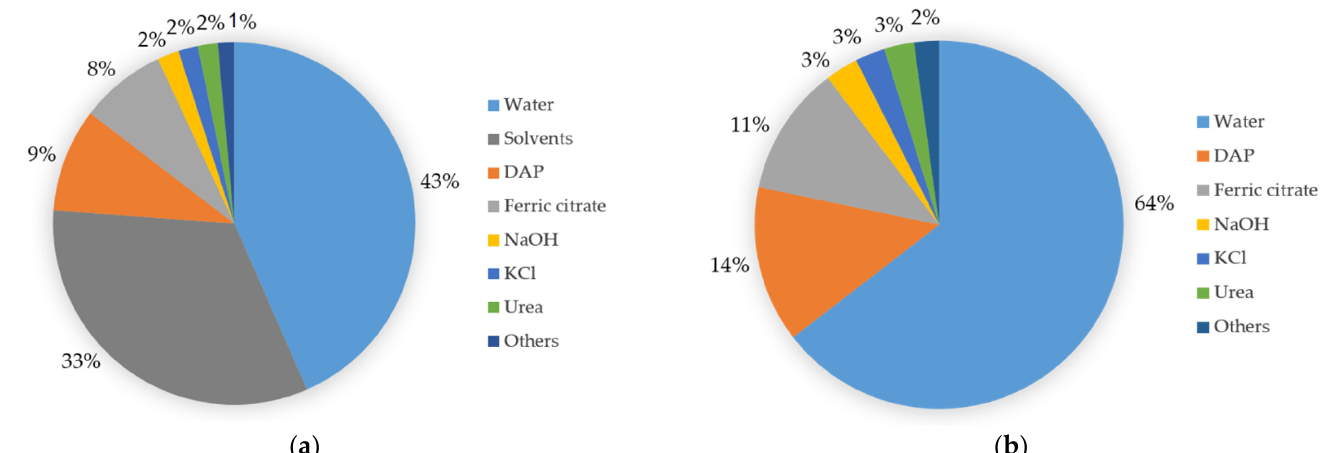
Figure 9. Distribution of raw material cost in the scenarios analyzed for lipid production: ( a ) scenario 1 and 2; ( b ) scenario 3.